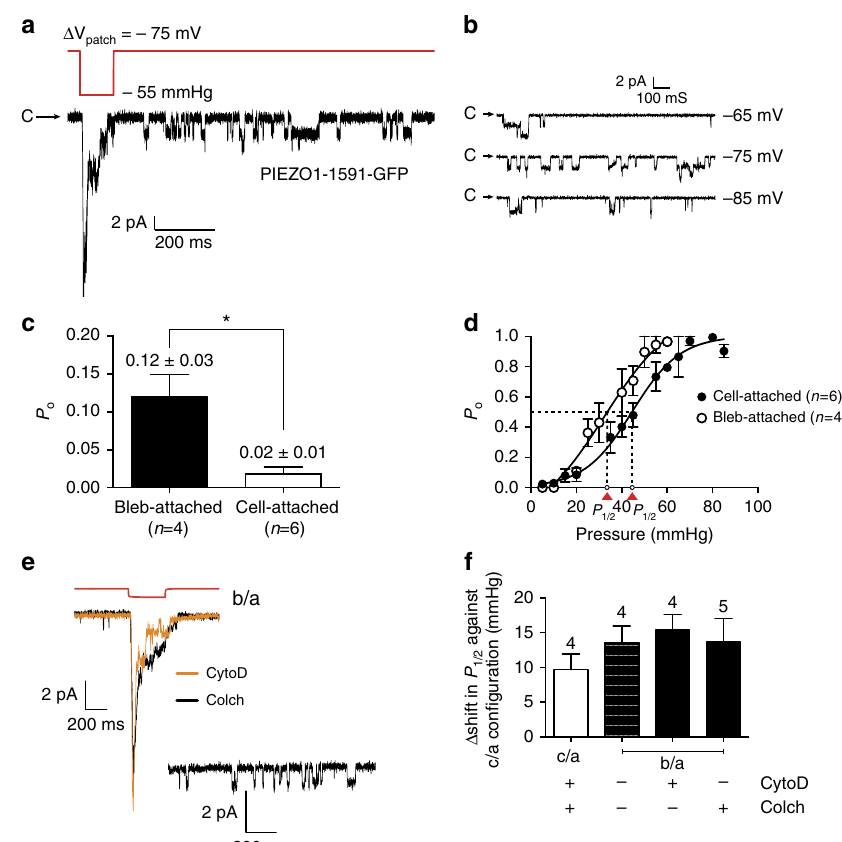
Figure 8 | Activation of the PIEZO1–1591–GFP fusion protein in bleb-attached patches in comparison with cell-attached. ( a ) Mechanosensitivity of PIEZO1–1591–GFP in bleb-attached patches in response to a 150ms square wave pressure pulse of (cid:2) 55mmHg (pipette: CsCl). ( b ) Single-channel activity at rest as seen post pressure at three different voltages. ( c ) The increase in P o at zero pressure is calculated using 5s records. There is at least a fivefold increase in basal activity (* P o 0.01; Student’s t -test). ( d ) Leftward shift in Boltzmann distribution function in bleb-attached patches (cell-attached P 1/ ± 2mmHg; n ¼ 6: bleb-attached P ± 3mmHg; n ¼ 4). ( e ) Example traces of PIEZO1–1591–GFP activated in blebbed membranes pre-treated 2 ¼ 44 1/2 ¼ 33 with Cytochalasin D (CytoD) 10 m M and colchicine (Colch) 10 m M. Cells were treated for 1h pre-blebbing, then blebbed in the presence of these agents for 2h using a hypo-osmotic solution. Final patch-clamp electrophysiology was carried out immediately with the bath solution again containing the same pharmacological agents. ( f ) Quantification of leftward shift of P 1/2 between cell-attached patches and bleb-attached patches with the identified cytoskeletal interfering agents (c/a, cell-attached; b/a, bleb-attached; data represents mean ± s.e.m.; n ¼